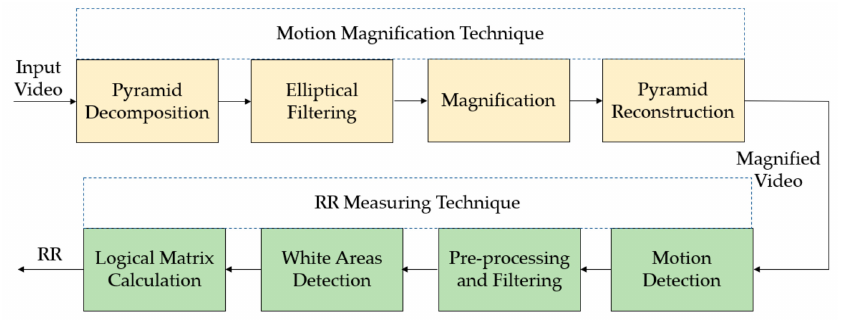
Figure 4. System diagram of the remote respiratory monitoring system